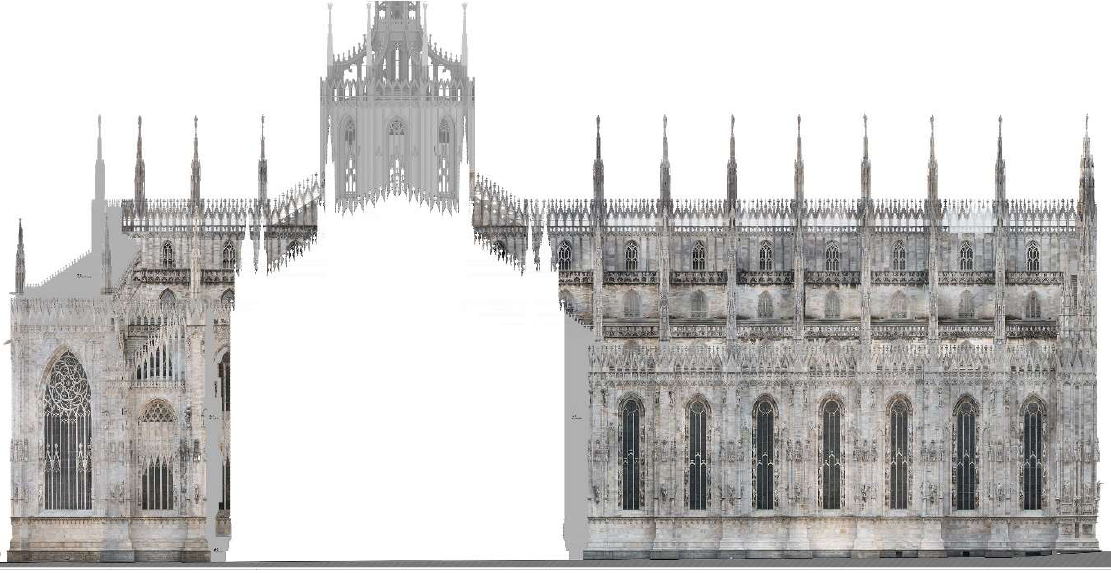
Figure 10. Ortophoto of the North façade: 4902 images, around 1.4 billion pixels (GSD 2mm), 156m long.